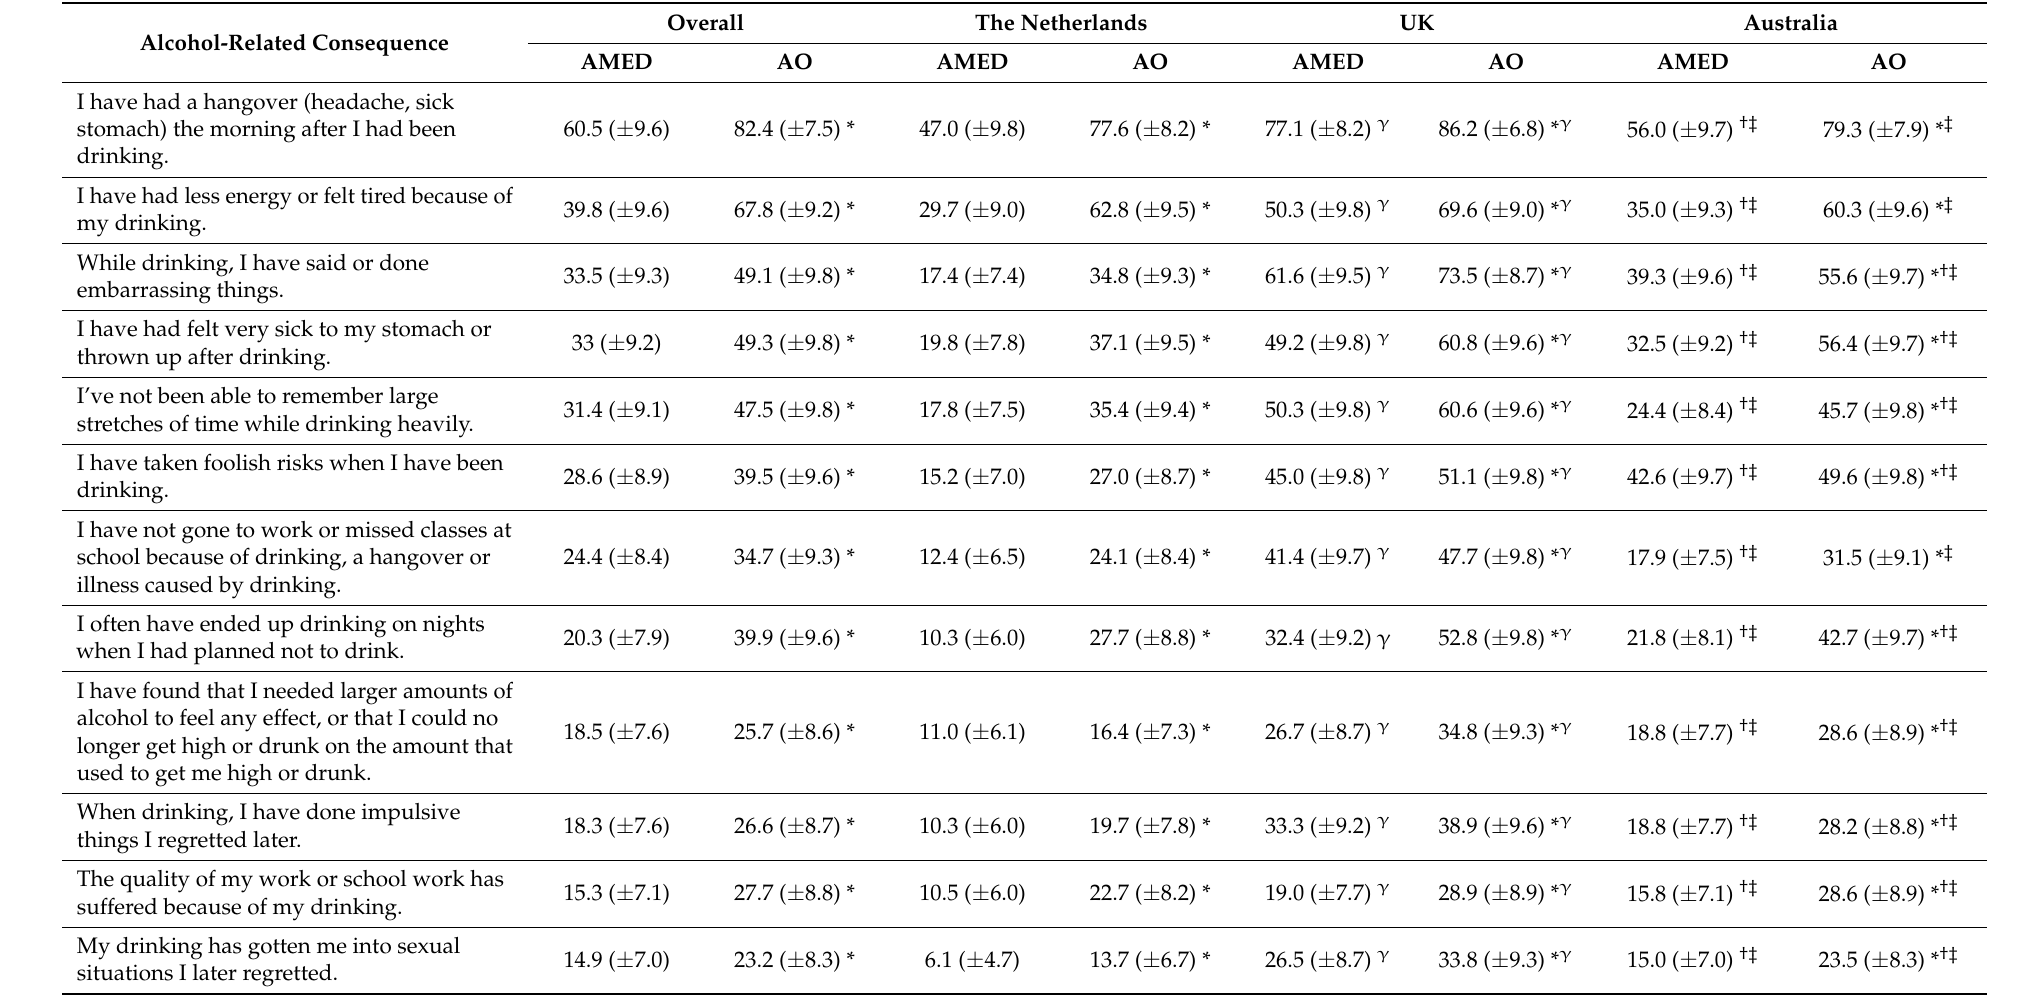
Table 6. Alcohol related